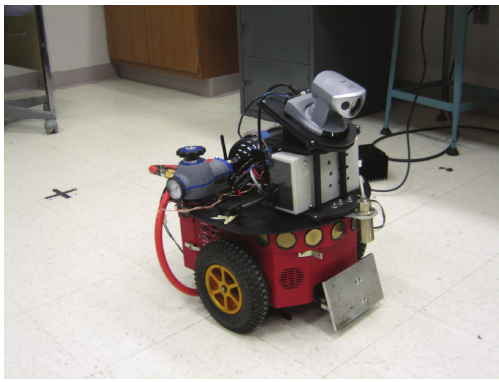
Figure 1: The kicking mechanism mounted on a Pioneer 3-DX